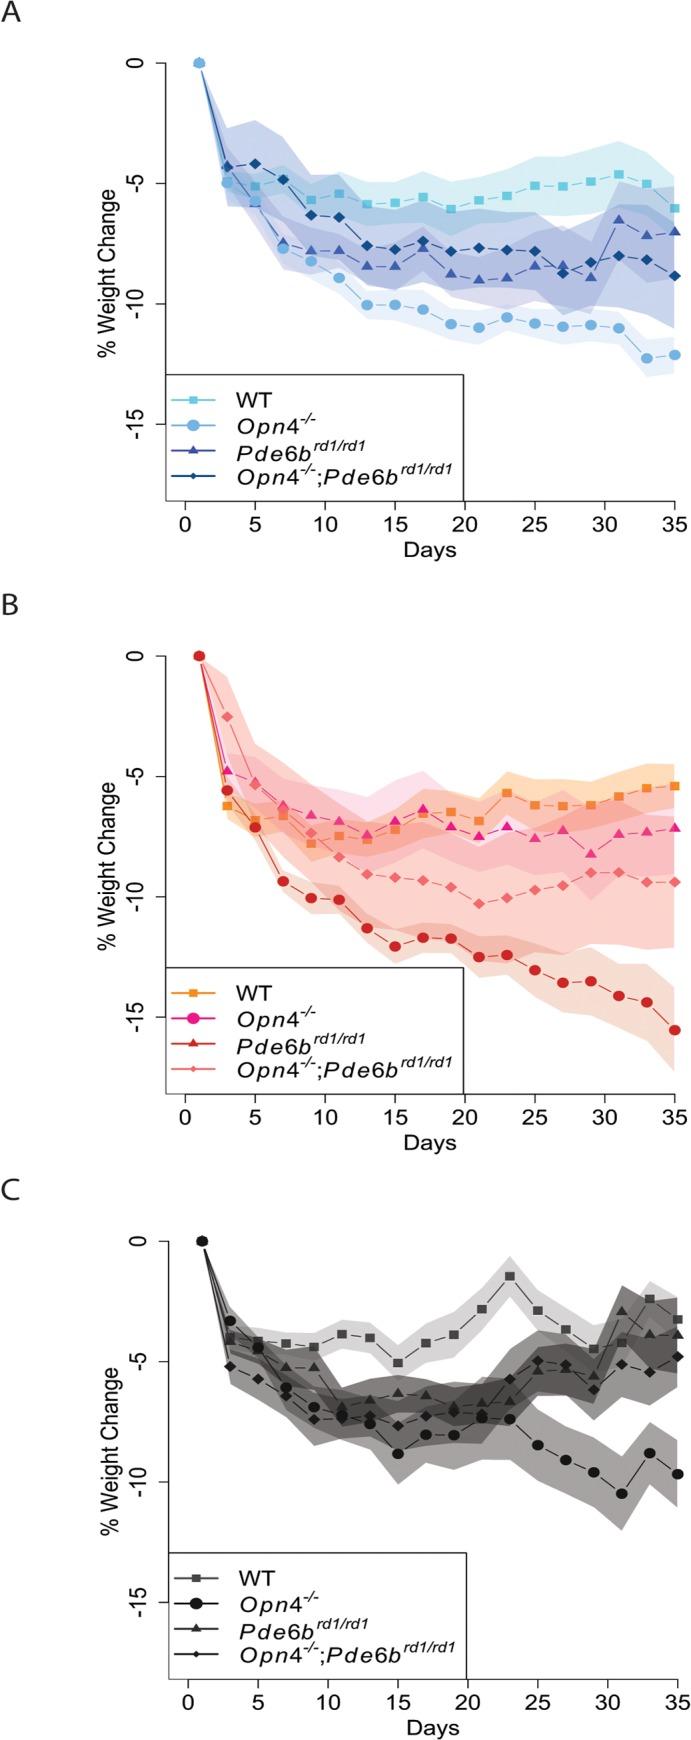
Analysis of all genotypes and light groups reveals significant effects of light regime (p<0.01) and genotype (p<0.0001) on weight change.Several genotypes and light groups demonstrate pronounced differences in the second half of the experiment. Overall analysis indicates Opn4
-/- mice are significantly different in their weight change pattern than WTs (p<0.0001), but they are also different from Opn4
-/-
; Pde6
rd1/rd1 animals (p<0.05). Red LD condition causes more weight change than constant darkness over 5 weeks on the ketogenic diet challenge (p<0.01). A week by week analysis reveals the following differences in addition to the ones already mentioned in the legend of Fig 1: A) All genotypes under 12h:12h blue LD condition (end of week 2: WT vs Opn4
-/-, p = 0.0002; end of week 3: WT vs Opn4
-/-, p = 0.0001; end of week 4 and 5: WT vs Opn4
-/-, p<0.0001). B) All genotypes under 12h:12h red LD condition (end of week 4: Opn4
-/- vs. Opn4
-/-
; Pde6
rd1/rd1, p = 0.001; end of week 5: Opn4
-/- vs. Opn4
-/-
; Pde6
rd1/rd1, p<0.0001; Opn4
-/- vs. Pde6b rd1/rd1, p = 0.0002). C) All genotypes in constant darkness (end of week 4: Opn4
-/- vs. WT, p = 0.0016; end of week 5: Opn4
-/- vs. WT, p = 0.0002). Opn4
-/- mice in constant darkness lose significantly less weight than the ones in red LD by the end of week 5 (p = 0.0004). RM-ANOVA, followed by Tukey-Kramer post hoc analysis. (For the weekly contrasts, alpha value was adjusted to 0.0017—Dunn-Sidak correction for contrasts. Fig 2 includes data replotted from Fig 1 to demonstrate the full effects of all genotypes and light conditions. Under both blue and red LD cycles: Opn4
-/- n = 9, WT n = 12, Pde6
rd1/rd1 n = 7, Opn4
-/-
; Pde6
rd1/rd1 n = 5. Under constant darkness: Opn4
-/- n = 8, WT n = 8, Pde6
rd1/rd1 n = 8, Opn4
-/-
; Pde6
rd1/rd1 n = 6.)